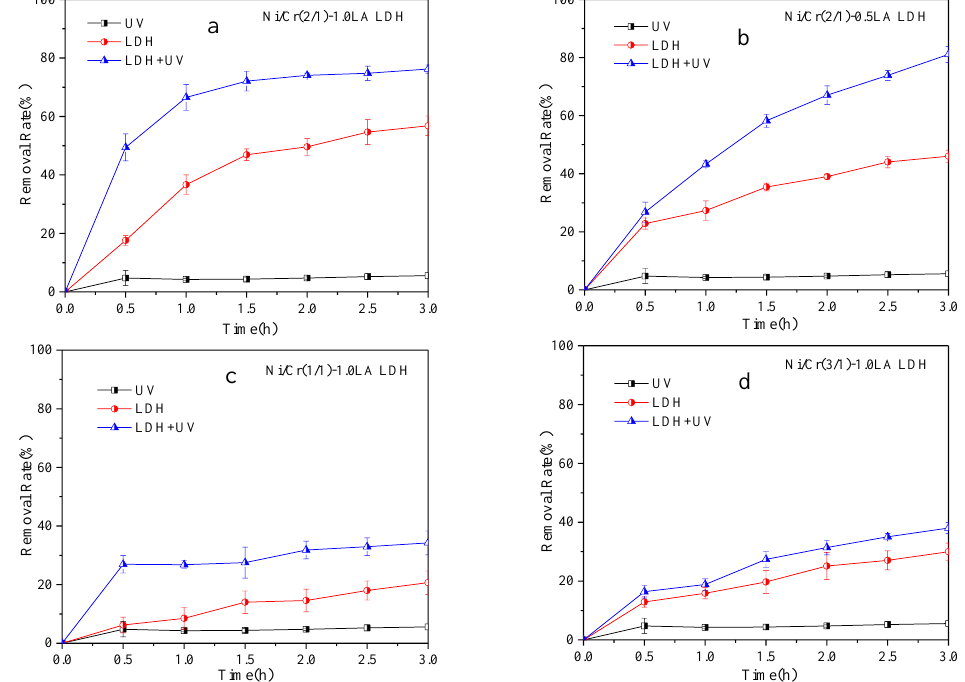
Figure 6. Photocatalytic degradation of MO over ( a ) Ni/Cr(2/1)−1.0LA LDH, ( b ) Ni/Cr(2/1)−0.5LA LDH, ( c ) Ni/Cr(1:1)−LA LDH, and ( d ) Ni/Cr(3:1)−LA LDH.